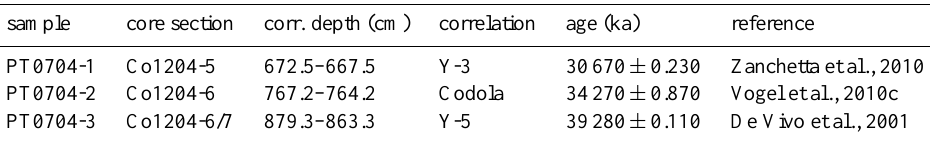
Table 2. Tephra horizons, depths, correlation with tephras from other records, and inferred ages in core Co1204 from Lake Prespa (for details see Sulpizio et al.,